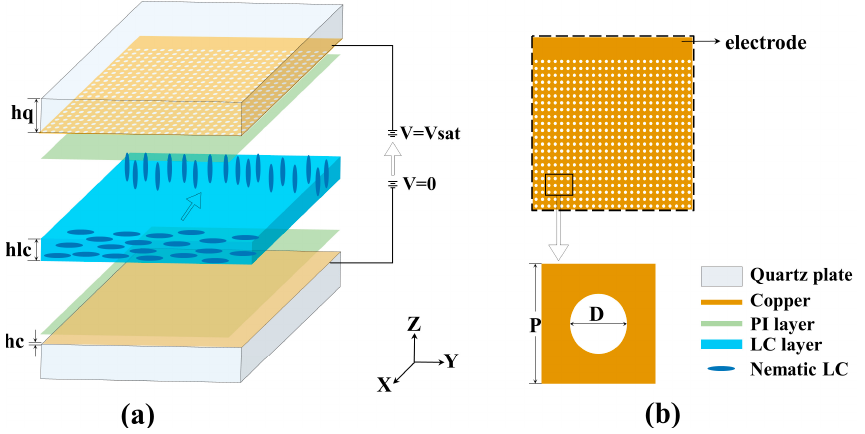
Figure 1. ( a ) Unit-cell structure and direction of the LC molecules in two states. ( b ) Layout of the unit-cell structure with the copper pattern. Table 1. The parametric dimensions of the FSS structure.